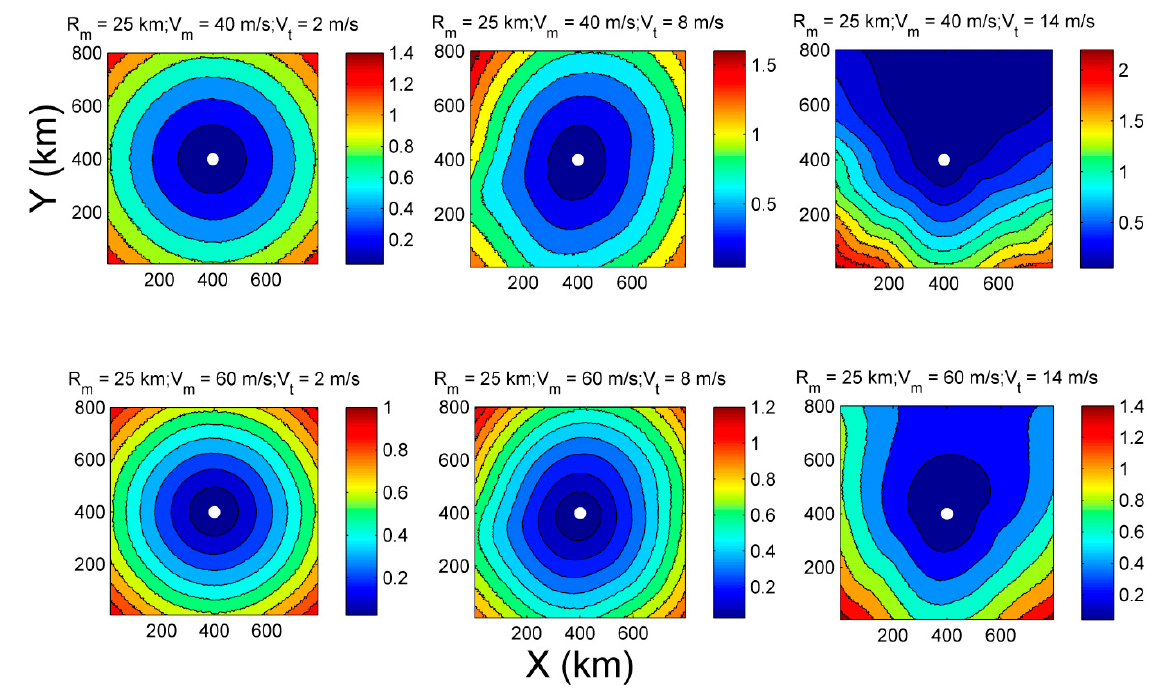
Figure 2. The spatial variation of H # for different TC characteristics (as listed in the subtitle). The above results indicate that TC translation has a significant impact on the azimuthal variation of H # and T # , but their respective effects appear to be different. To detail the influence of V t on the two parameters, we plot the half-sector-averaged values of H # and T # against the seven V t values in Figures 4 and 5, respectively. The subfigures correspond to the results corresponding to different values of V m and R m . The H # at radial distances of R m (dashed lines) and 4R m (solid lines) from the TC center are given to check the radial variation, and the front sector and back sector correspond to the red lines and blue lines,